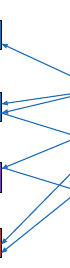
Figure 9. Schematic diagram of the traditional relationship between the linear properties and power system